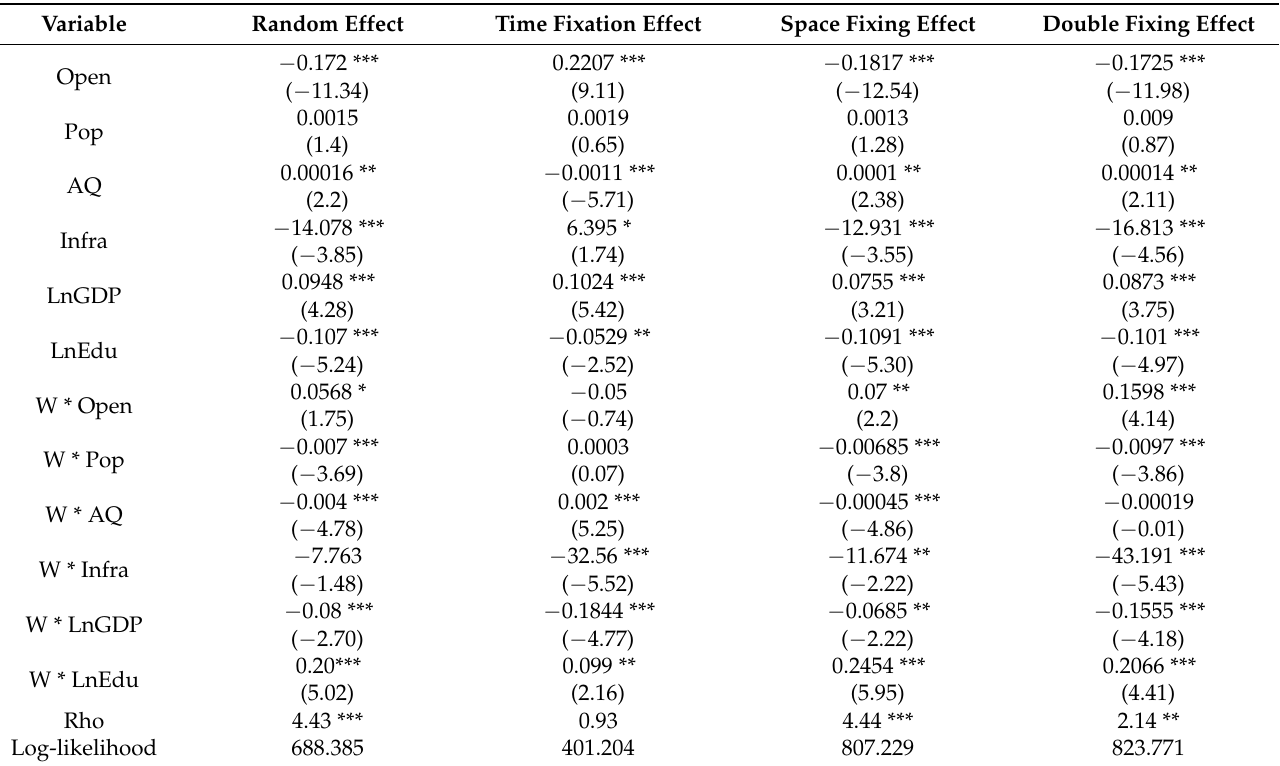
Table 6. SDM regression